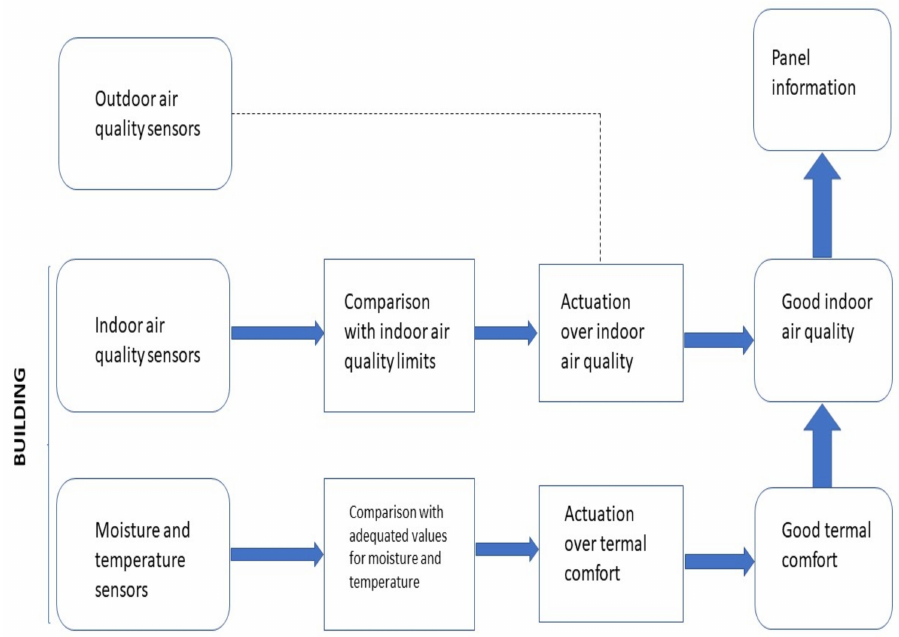
Figure 9. Architecture of an integrated system for controlling both indoor air quality and thermal